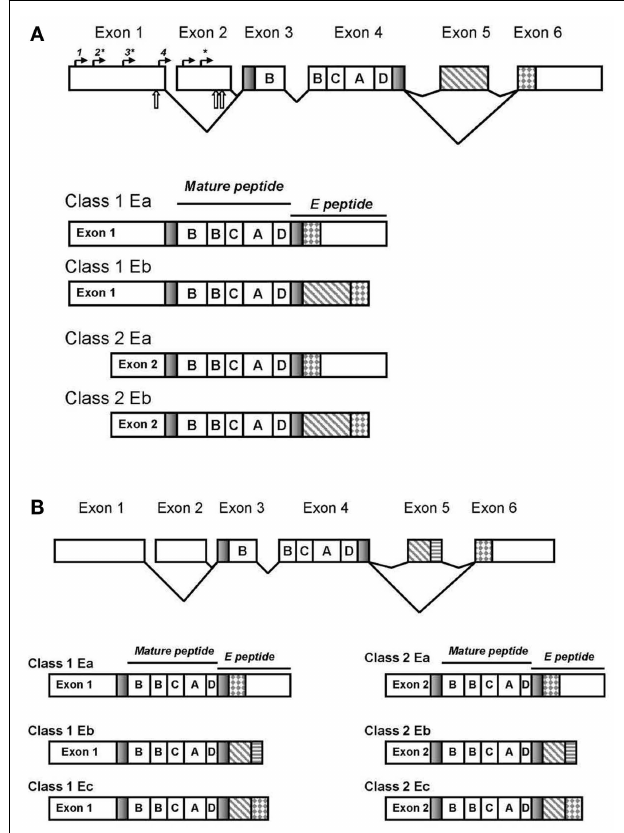
FIGURE 1 |The IGF-1 gene structure. Splicing and exons in the rodent gene generate distinct transcripts that vary in the 5 (cid:48) and 3 (cid:48) ends though the mature peptide is invariant (A) .Transcription initiation sites are denoted by solid arrows above the exons: sites designated 1–4 are ∼ 382, 343, 245, and 40 bases upstream of the 3 (cid:48) end of exon 1, respectively and the two sites in exon 2 ∼ 70 and 50 bases upstream of the 3 (cid:48) end of exon 2. Sites preferentially used are indicated with asterisks.Translation initiation is denoted with open arrows below the exons.The human IGF-I transcripts are depicted in (B)